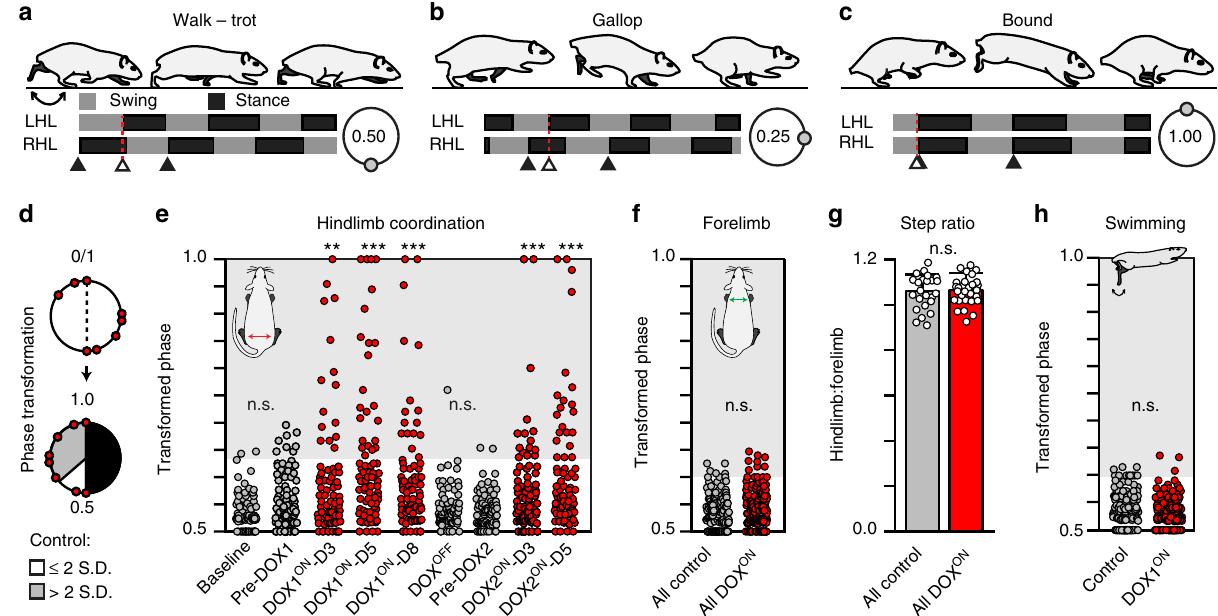
Fig. 4 Silencing L2 – L5 interneurons selectively disrupts left – right hindlimb alternation during overground stepping. a – c Stereotypic locomotor gaits with representative swing – stance graphs and characteristic left – right hindlimb coordination values (shown in circular plots, see Methods for detail). d Schematic illustrating phase transformation (see Methods for detail). Shaded area denotes any coordination value beyond normal variability observed ( > 2 S.D.) at control time points. Each circle represents one step cycle ( n = 84/time point; n = 10 – 14/animal). e Silencing L2 – L5 interneurons signi fi cantly increased the proportion of steps that deviated beyond normal variability observed at control time points. Removing DOX restored alternation and silencing one month later repeated the effects (Baseline, n = 3/84 vs. DOX1 ON , n = 15/84 ( p = 0.002, z = 3.08), 24/84 ( p < 0.001, z = 4.69), 17/84 ( p = 0.001, z = 3.45); Pre-DOX2, n = 2/84 vs. DOX2 ON , n = 15/84 ( p = 0.001, z = 3.44), 21/84 ( p < 0.001, z = 4.52); ** p ≤ 0.01, *** p ≤ 0.001; Binomial Proportion (B.P.) Test). Control time points were not signi fi cantly different from each other (Baseline vs. Pre-DOX1, p = 0.116, z = 1.57; DOX OFF vs. Pre-DOX2, p = 0.562, z = 0.58). f Left – right forelimb alternation was not perturbed (All control vs. All DOX ON , p = 0.322, z = 0.99). g No differences were observed in the hindlimb/ forelimb stepping index (circles = individual animal ’ s average hindlimb:forelimb step ratio at each time point; Control: N = 24 total average step ratios; DOX: N = 30 total average step ratios; bars represent group average ± S.D.; p = 0.75, critical t = 2.003, df = 52, two-sample t -test). h Left – right hindlimb alternation persisted during swimming ( n = 80 stroke cycles/time point; p = 0.20, z = 1.28, B.P. test). In a-c, classic gait data were generated from a separate study, see Methods for detail. Illustrations by A.